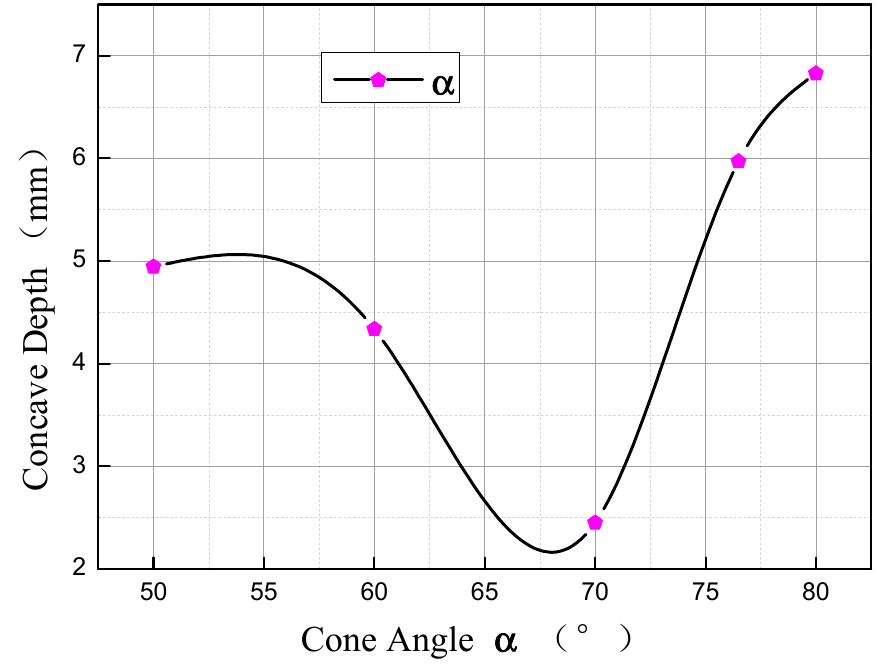
Figure 13. Influence of cone angle α on concave depth.